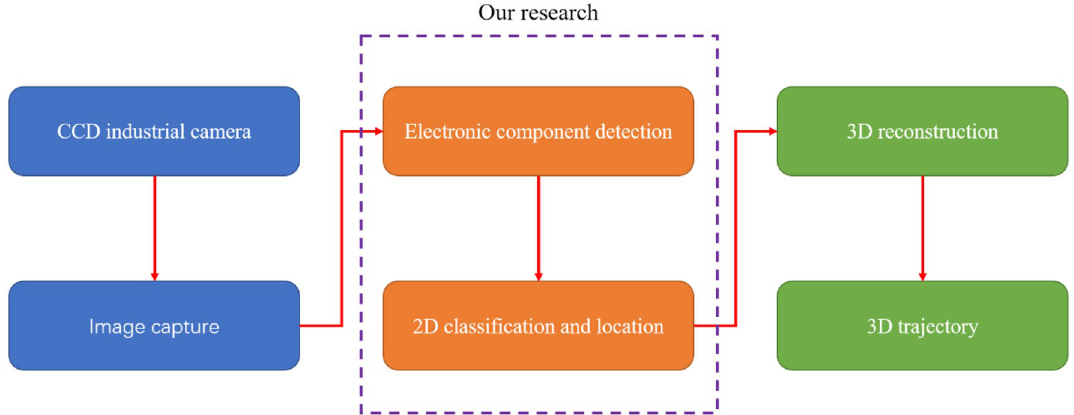
Figure 1. Robot vision system in the electronics manufacturing industry. First, a CCD industrial camera is used to collect images of electronic components, then algorithms are used to perform two-dimensional detection of electronic components. Lastly, three-dimensional reconstruction of the obtained two-dimensional classification and positioning information is performed to obtain the corresponding trajectory.